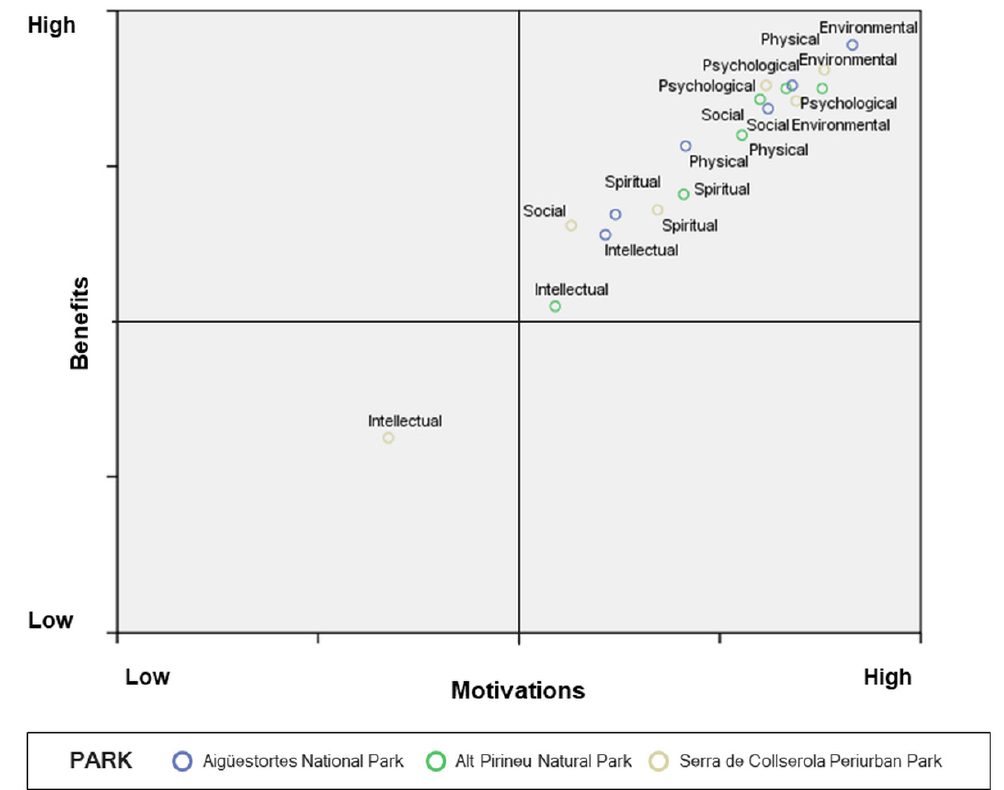
Figure 3. Motivation–benefits gap analysis for the three PNAs.